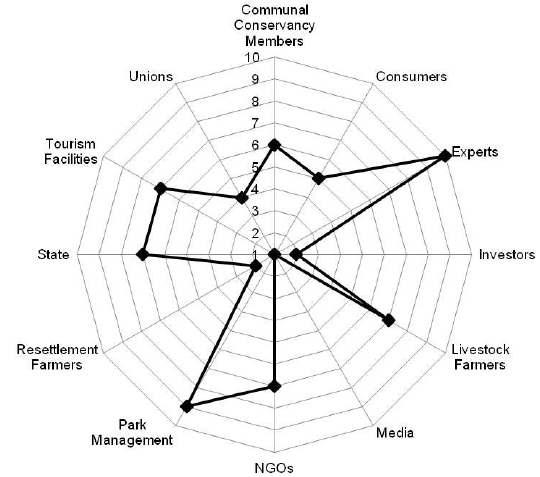
Fig. 3 . Median interest scores for the different stakeholder groups, including both primary and secondary stakeholders, classified according to stakeholder roles in the study system,